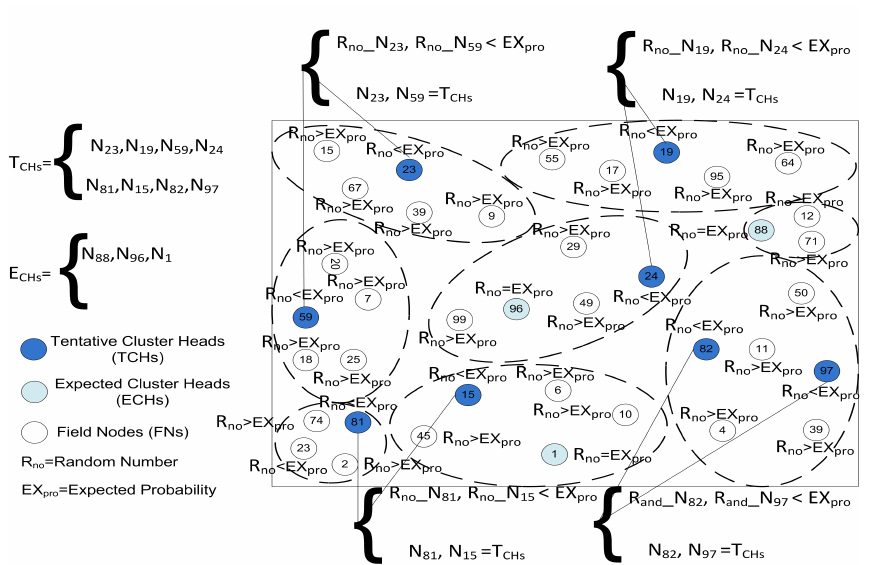
Figure 4. The tentative and expected CHs selection process of the proposed model on the basis of expected